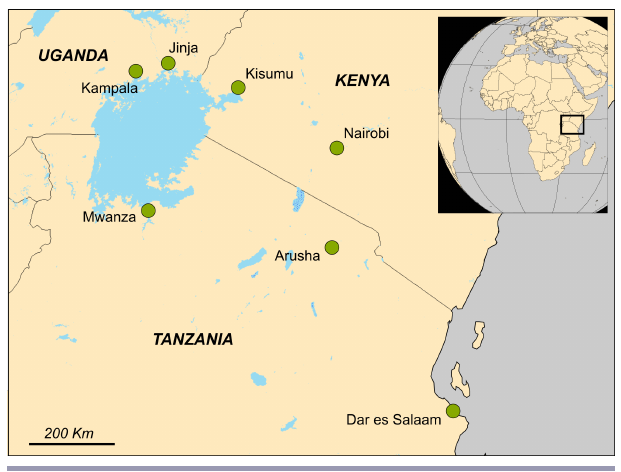
Fig. 2 . Map of the study region. Green circles indicate fieldwork